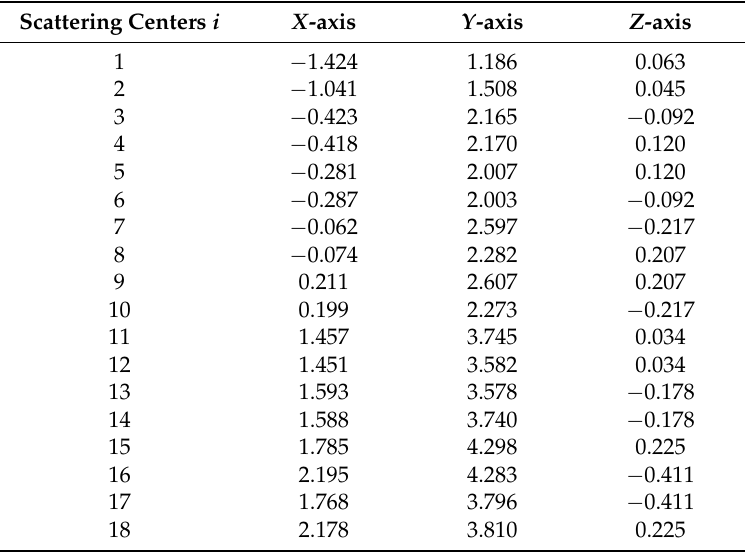
Table 2. Position coordinates of scattering centers at t CPA (m). Scattering Centers i X -axis Y